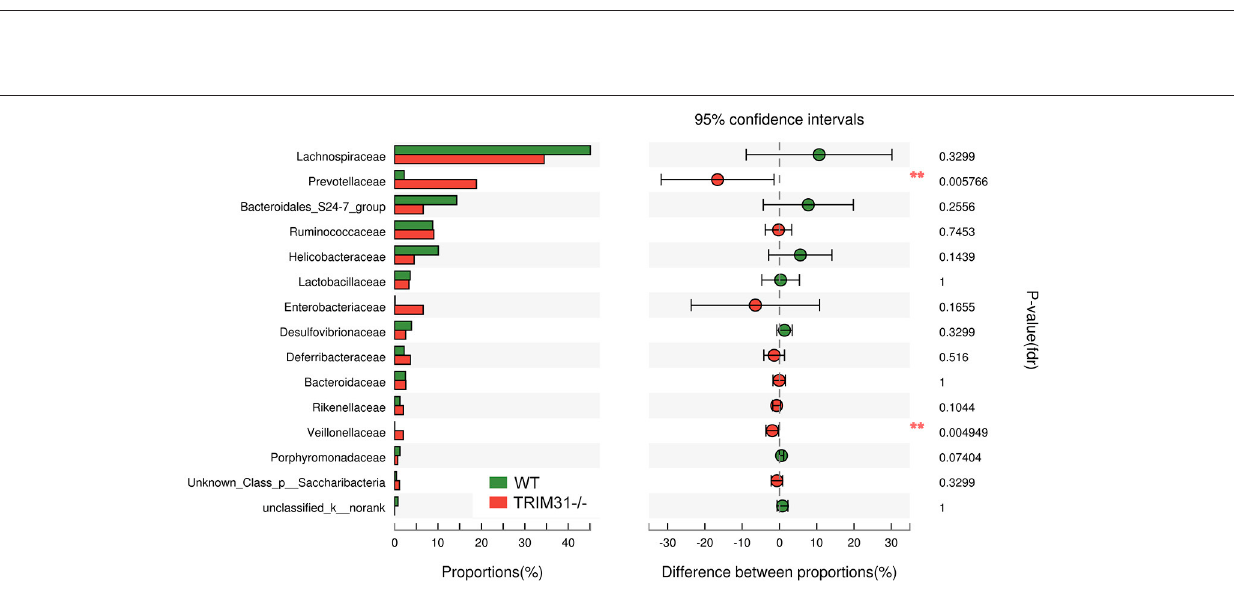
Frontiers in Physiology | www.frontiersin.org